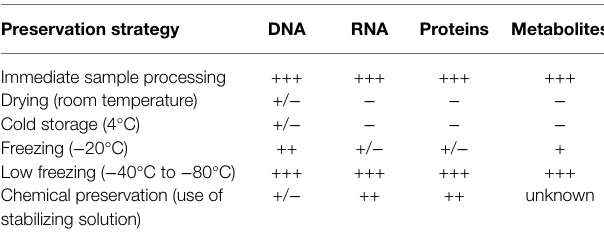
TABLE 1 | Influence of the conservation strategy of the soil sample on the quality of the extracted biological